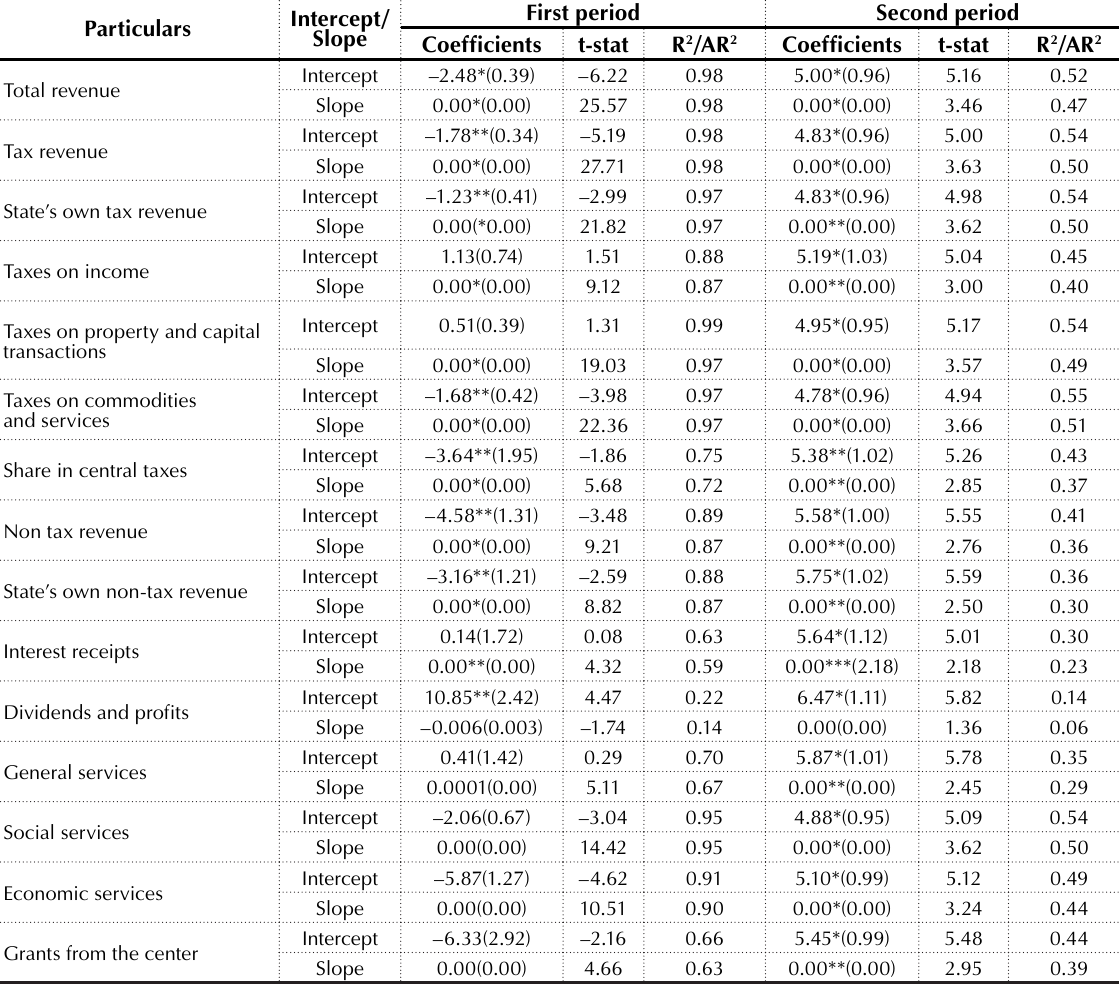
Table 5. Revenue receipts of the state